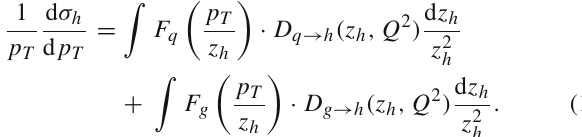
FFs at initial energy scale Q 2 = 1 . 5 GeV 2 (left panel) and the DGLAP evolved FFs at Q 2 = 100 GeV 2 (right panel).